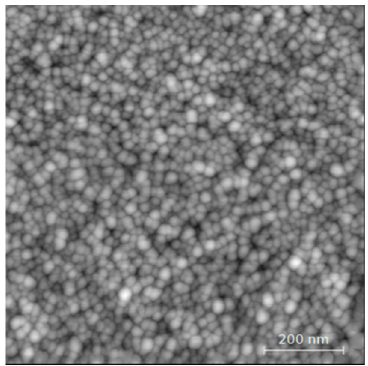
Figure 5. AFM image of a 25 nm thick ZnO:Ga.